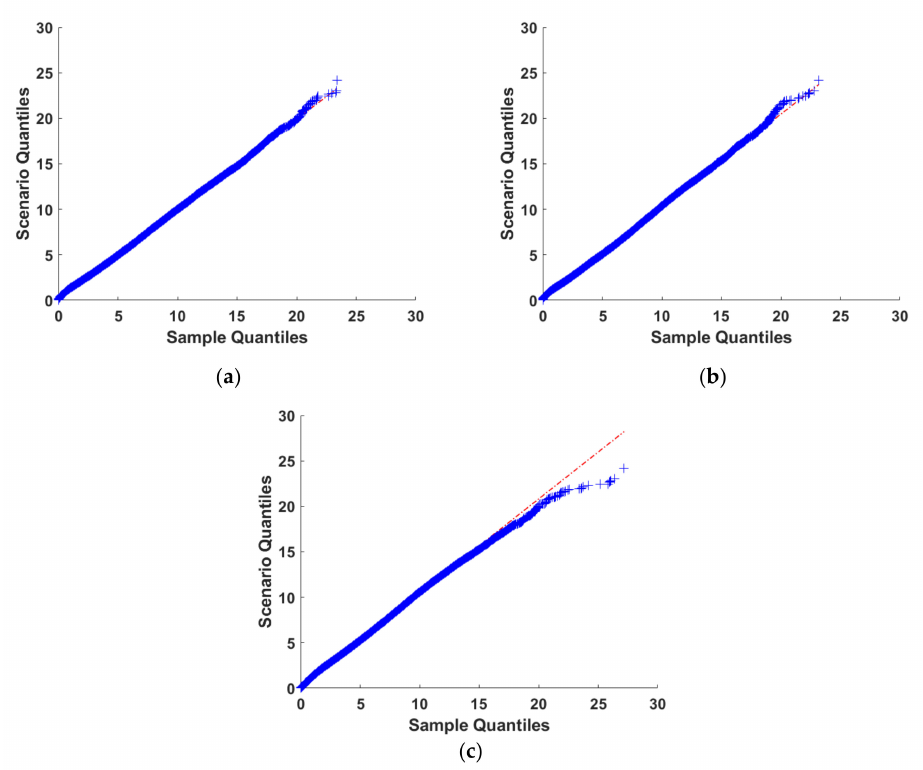
Figure 10. QQ plot for WF 2 of samples and scenarios generated using ( a ) the PC-R-vine model, ( b ) the PCA-ARMA model, ( c ) the HMCM